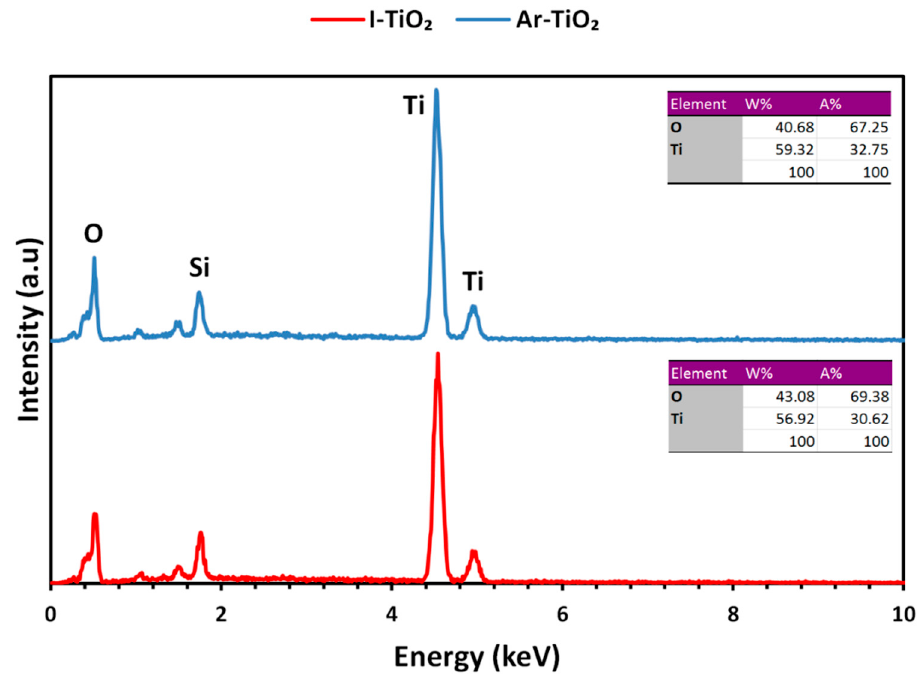
Figure 4. EDX spectrum of plasma-treated and non-treated TiO 2 nanoparticles immobilized on glass plates.